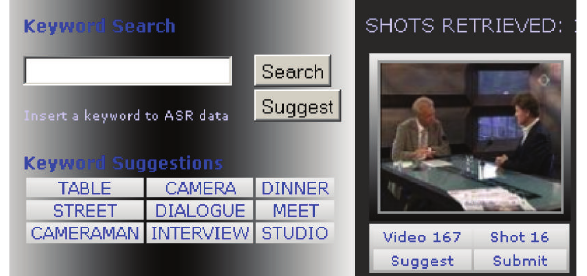
Figure 15: Keyword suggestions in a query by image example. The input image is the one at the right.